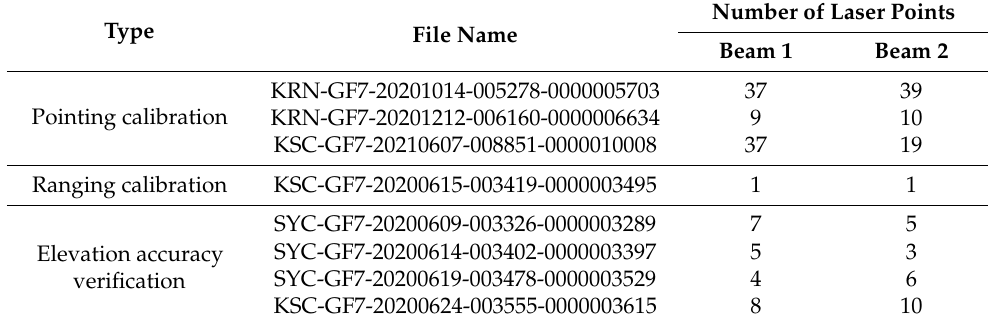
Table 1. The basic information of all test laser data of the GF-7 satellite in this study.